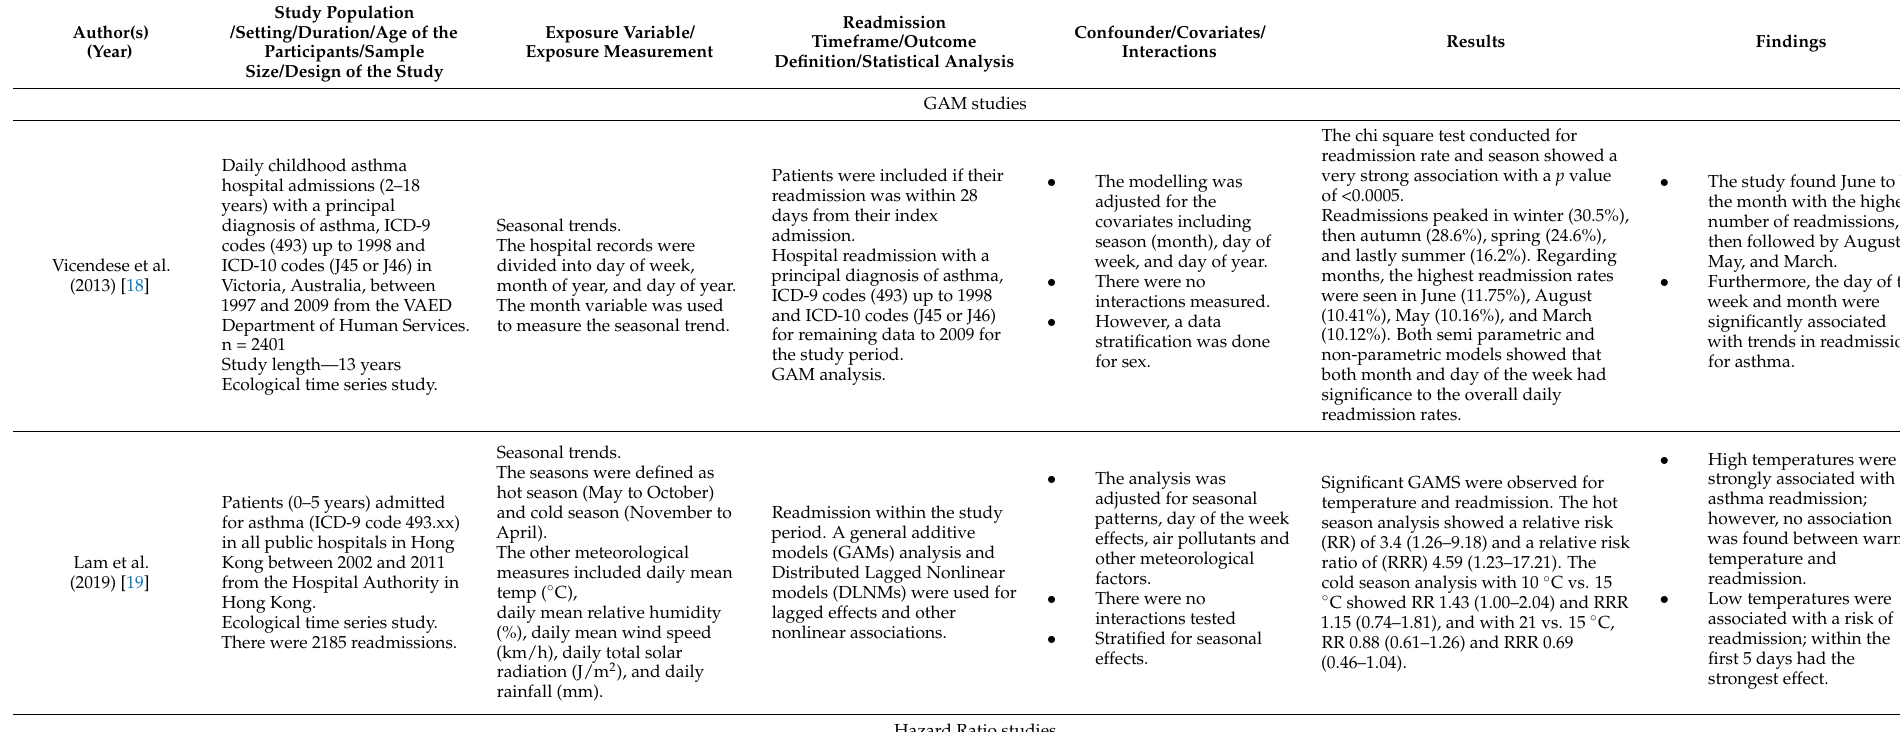
Table 3. The characteristics and findings of included GAM, Hazard Ratio, and Descriptive analysis